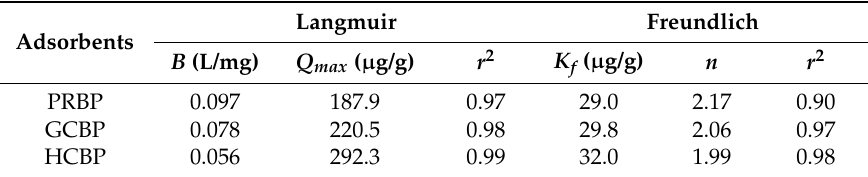
Table 3. The adsorption isotherm parameters of DCF.